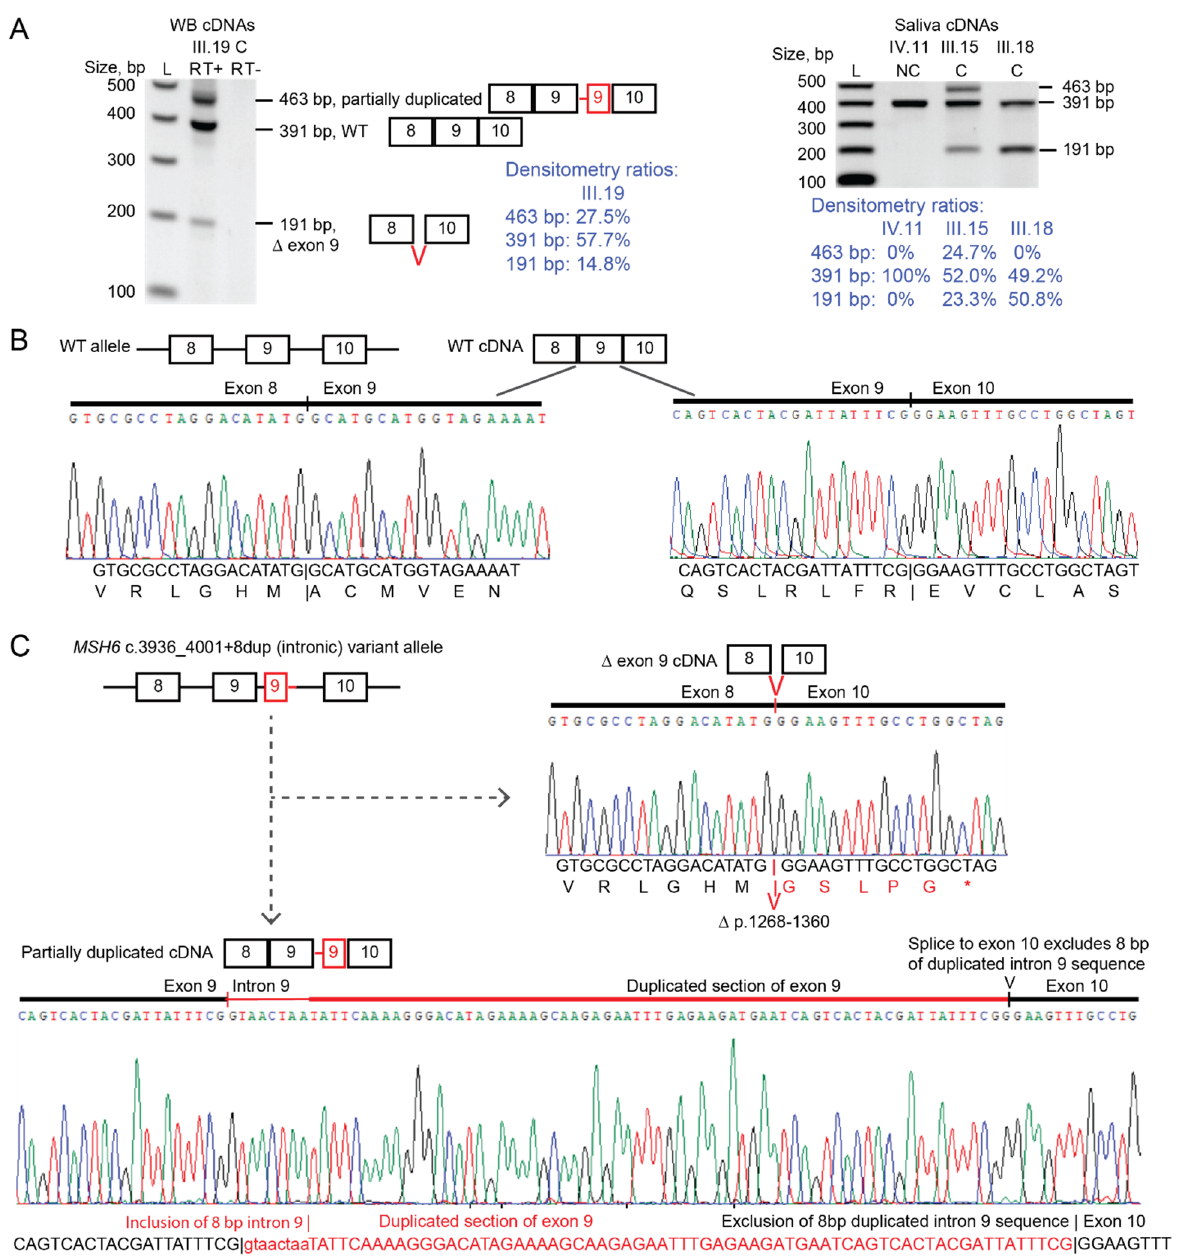
Figure 5. MSH6 c.3936_4001+8dup (intronic) is associated with two distinct out-of-frame splice variant transcripts. ( A ) Reverse-transcription (RT+)PCR products of MSH6 exons 8–10 from the saliva of a non-carrier (NC), and the white blood cells (WBC) and saliva (Sa) of MSH6 c.3936_4001+8dup (intronic) carrier, III.19, after electrophoretic separation show the normal-sized 391 bp fragment derived from the wild-type allele (containing exon 8, 9, and 10) and two distinct aberrant transcripts in WBC: the shorter 191 bp fragment contains exon 8 spliced directly to exon 10, indicating skipping of exon 9; the longer 463 bp fragment contains exons 8, 9, the first 8 nucleotides of intron 9, then the first 64 bp of the duplicated exon 9 sequence up to the point of the duplicated donor splice site, spliced onto exon 10. The final 8 bp of the duplicated intron 9 sequence contained within the genomic MSH6 c.3936_4001+8dup (intronic) sequence were absent (spliced out) from the longer transcript. Only the exon 9-skipped aberrant transcript was detected in the III.19 saliva. L, 100 bp ladder. RT-, omission of RT enzyme. ( B ) Electropherograms of cloned wildtype MSH6 transcripts across the expected splice sites derived from the normal allele. ( C ) Partial electropherograms and sequence texts of cloned cDNAs from the two predominant forms of aberrant mRNA transcripts derived from the MSH6 c.3936_4001+8dup (intronic) allele are shown with the translated amino acid sequences predicted by the ExPASy online Translate tool below, all in IUPAC (International Union of Pure and